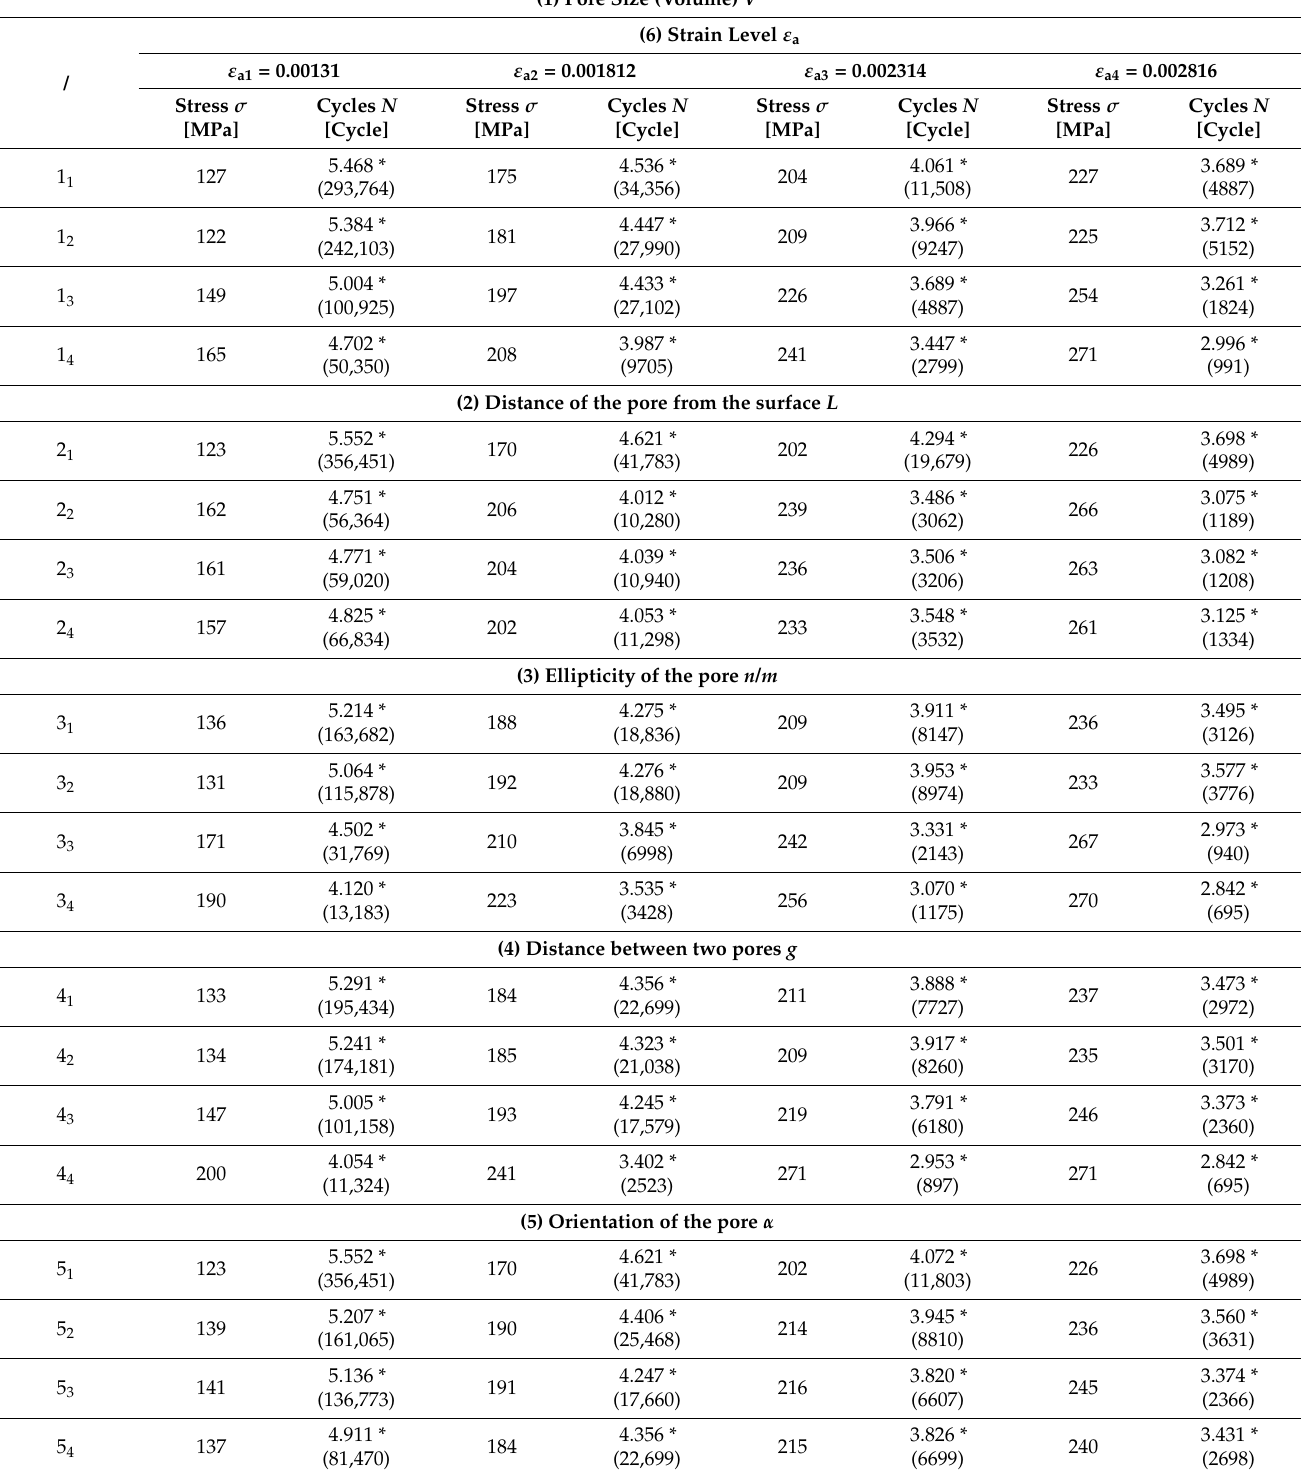
Table 2. Separate prediction of the reached stress σ and the fatigue life N for each geometric influence and strain levels ε a